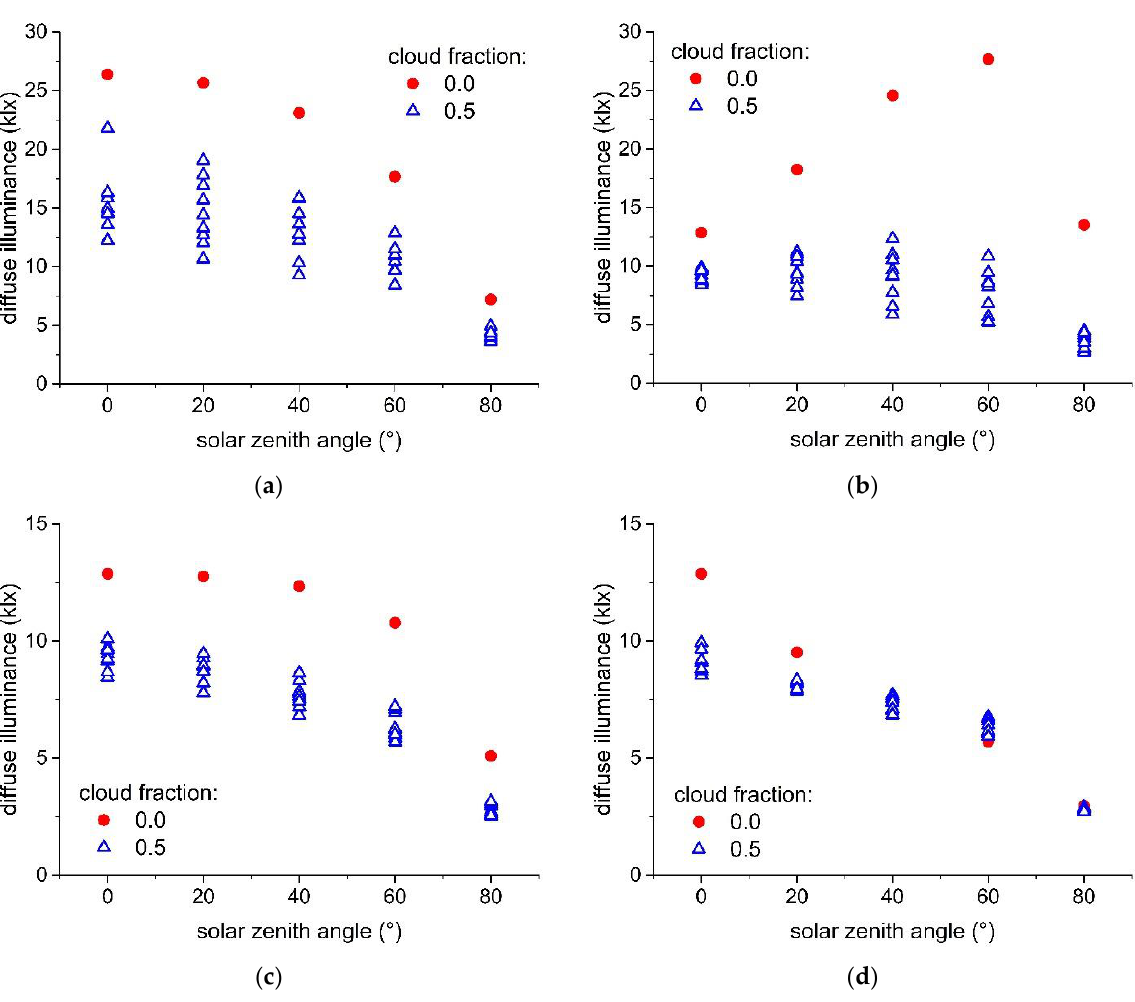
Figure 2. Diffuse illuminance on the horizontal plane ( a ) and vertical planes oriented to the south ( b ), east ( c ), and north ( d ) as a function of the solar zenith angle calculated for ten random distributions of identical clouds with the cloud frac- tion equal to 0.1.